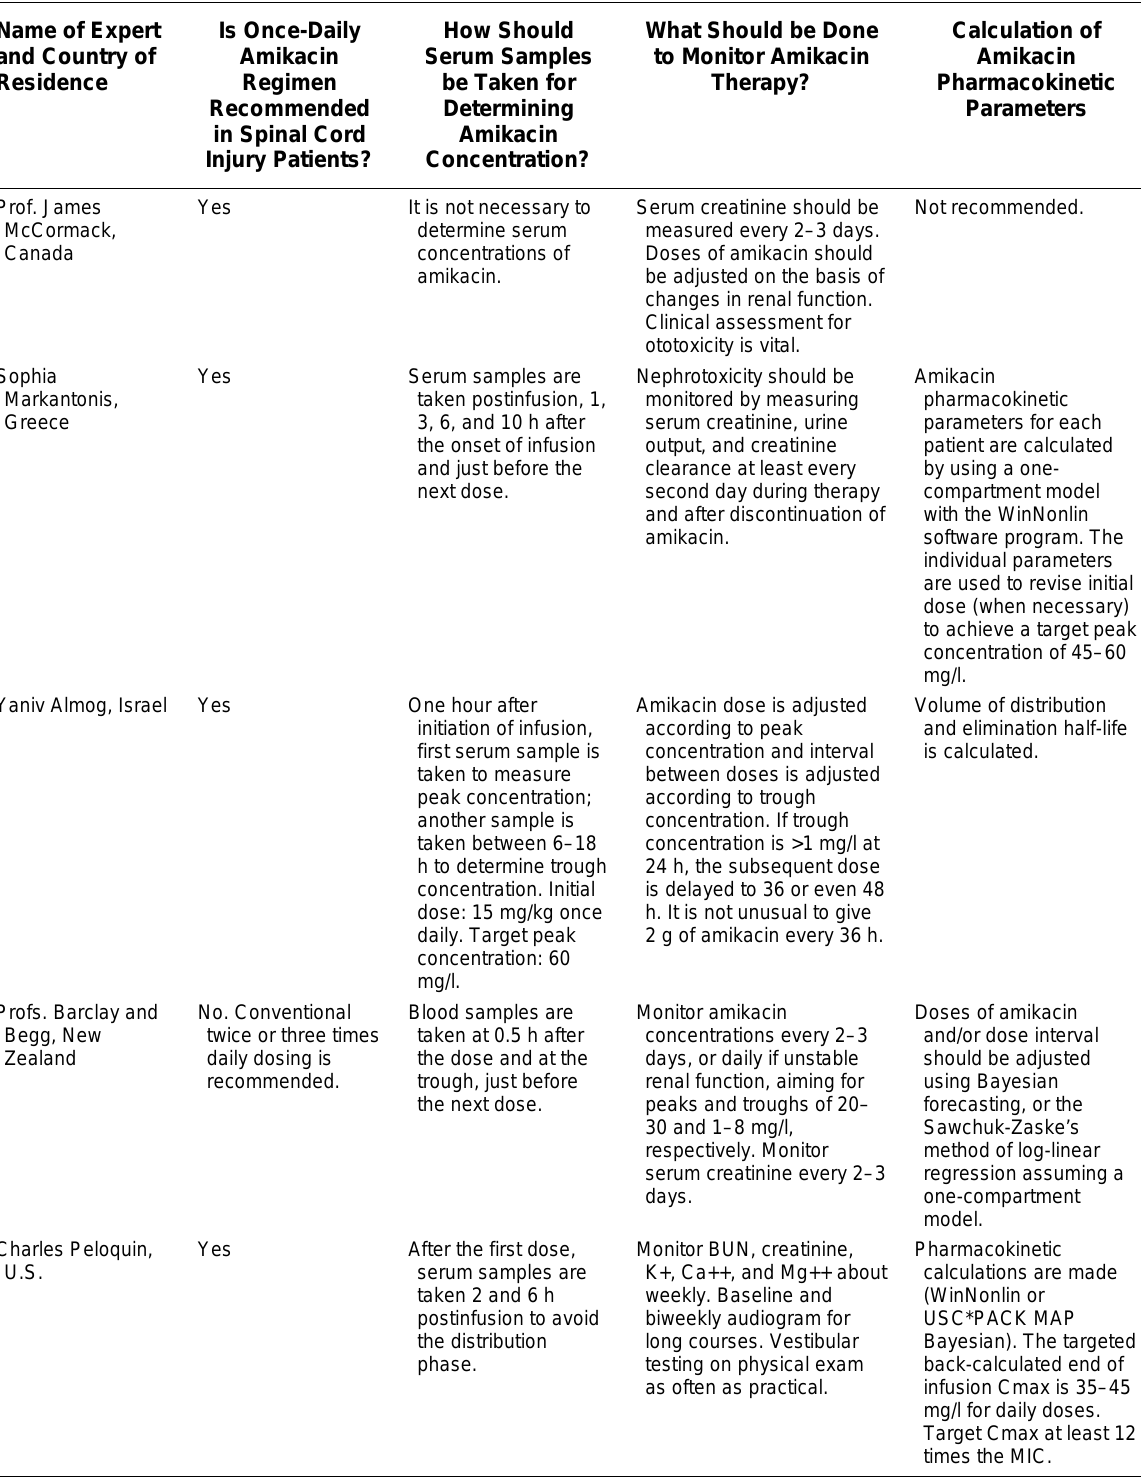
Summary of Recommendations of Experts from Canada, Greece, Israel, New Zealand, and the U.S. Regarding the Use of Amikacin in Spinal Cord Injury